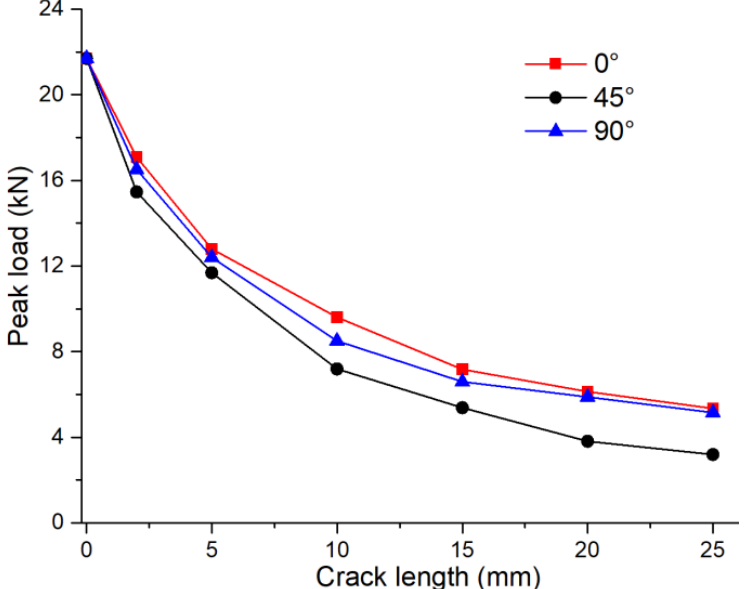
Figure 30. The peak load for Brazilian discs with cracks of different length. The crack angles are 0°, 45°, and 90°, respectively.